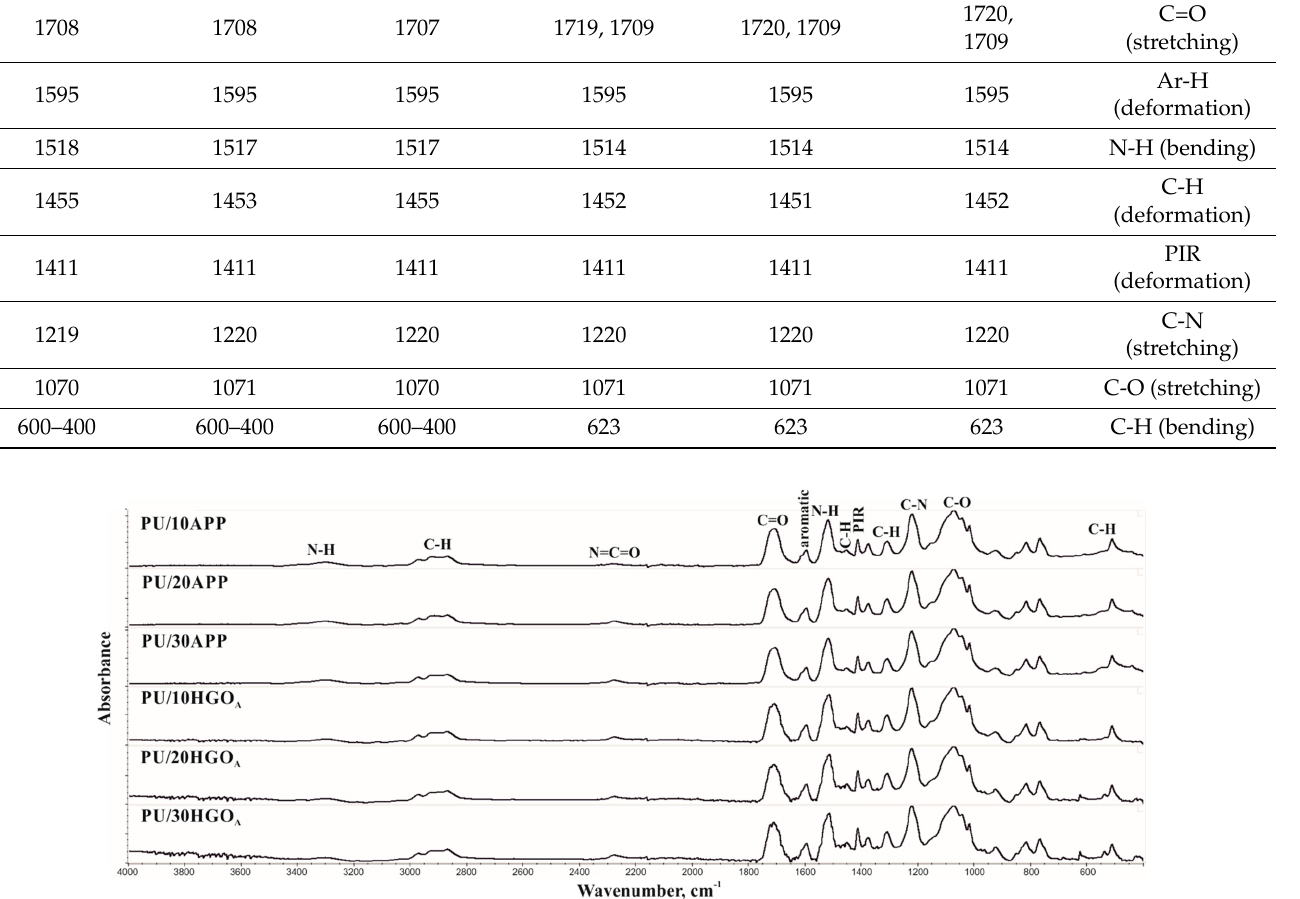
Table 3. The thermo-oxidative properties of H and GO A .